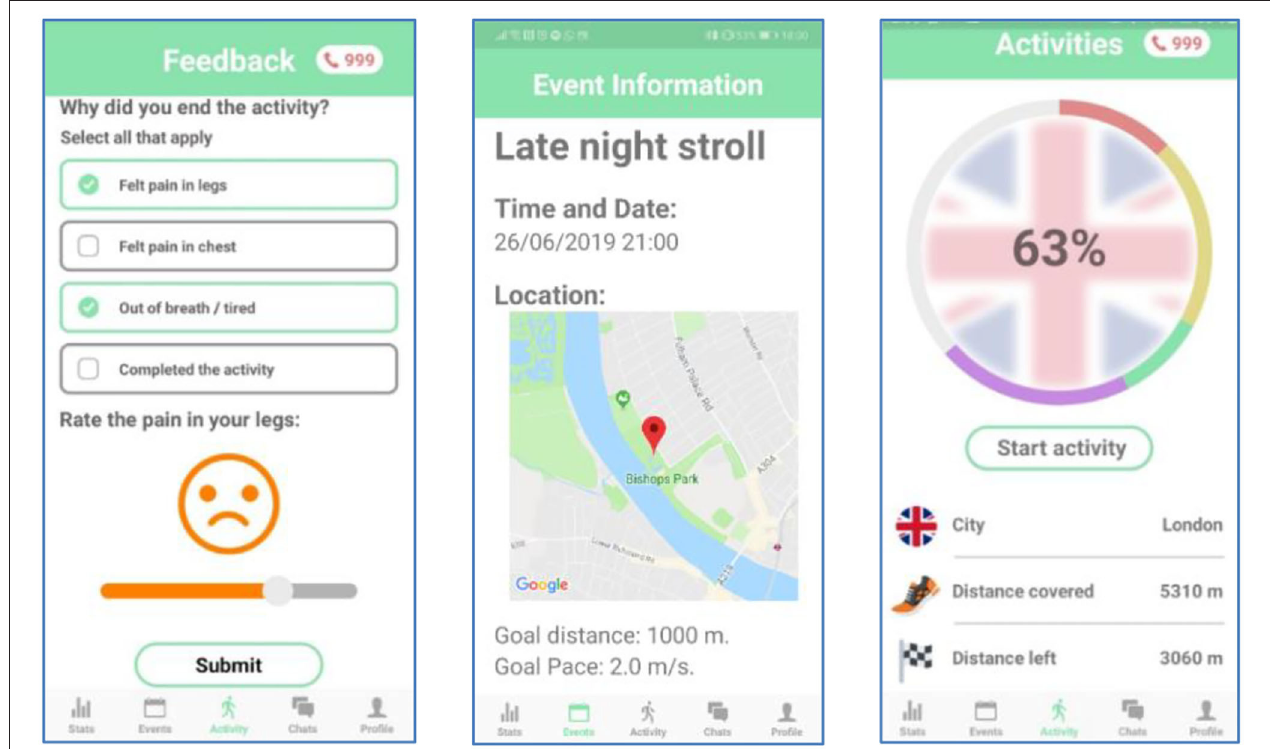
FIGURE 2 | Screenshots from the ORBIS